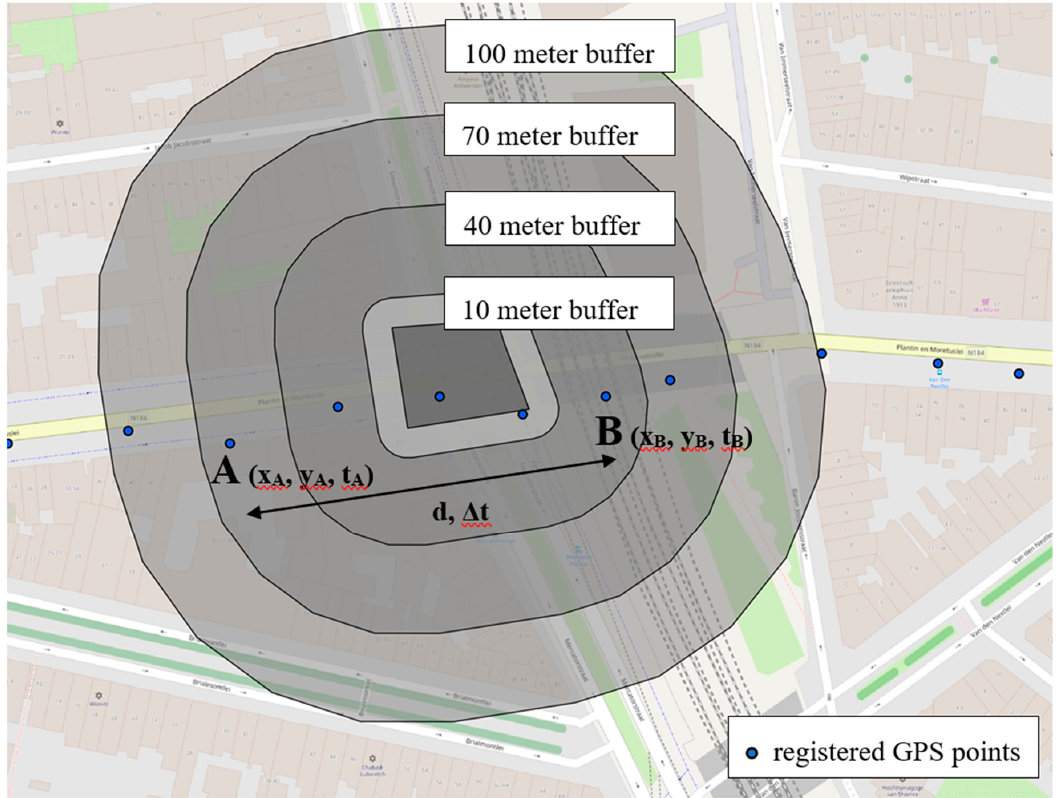
Figure 1. Application of the methodology for estimating the waiting time from the floating bike data for one registered trip.